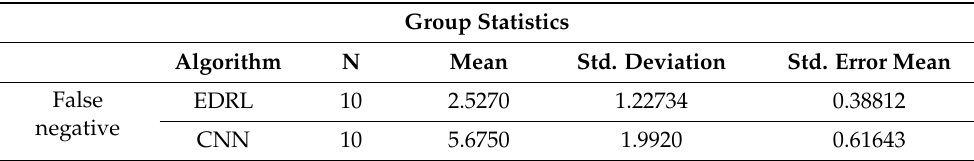
Table 11. Group statistics for false negative comparison of EDRL vs. CNN algorithms to measure the mean, standard deviation, and standard error mean.